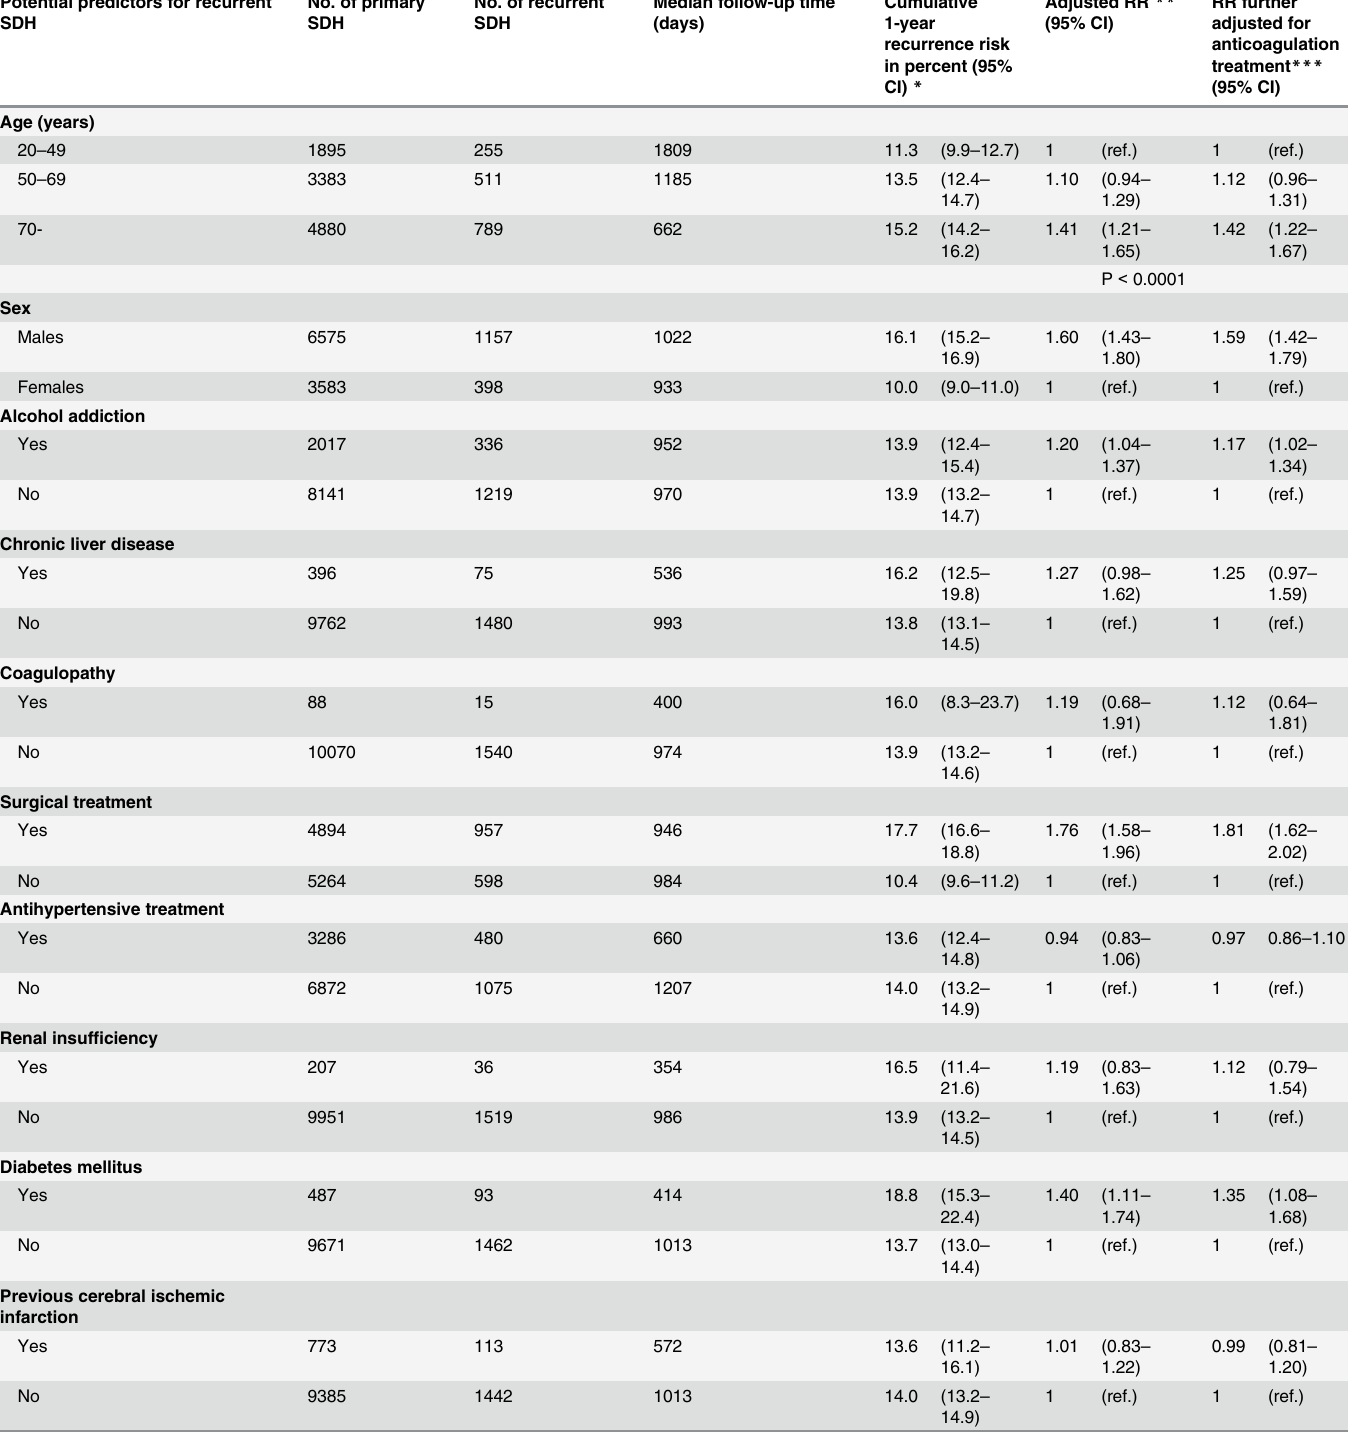
Table 1. Cumulative risks and rate ratios of recurrent subdural haematoma (SDH) according to concomitant medical diseases and other potential predictors in Danish SDH patients diagnosed 1996 –